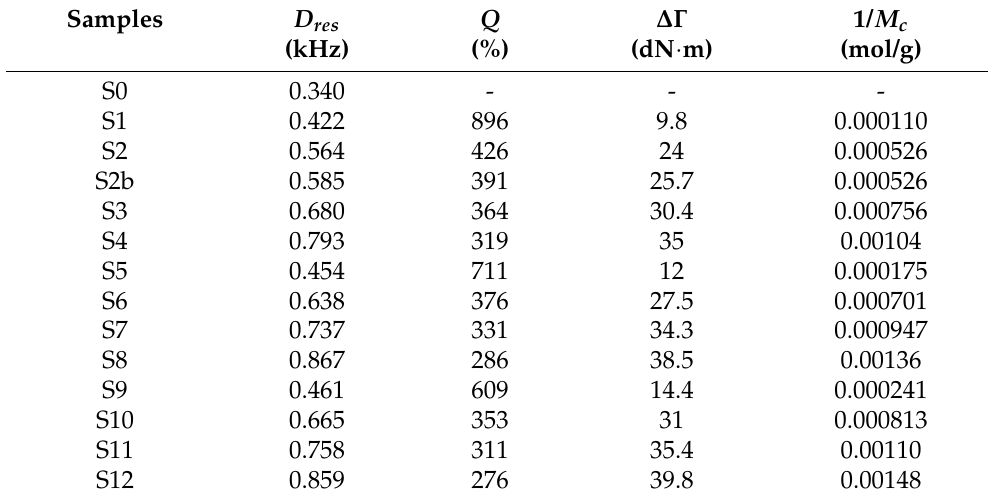
Table 2. NMR residual dipolar coupling D res (as determined from Equation (13)), equilibrium swelling ratio Q (ratio of swollen gel over polymer volumes expressed in %), and torque difference ∆Γ from rheometry measurements in the set of samples. The indicated inverse molecular mass values 1/ M c values are from swelling measurements, using parameter values indicated in the